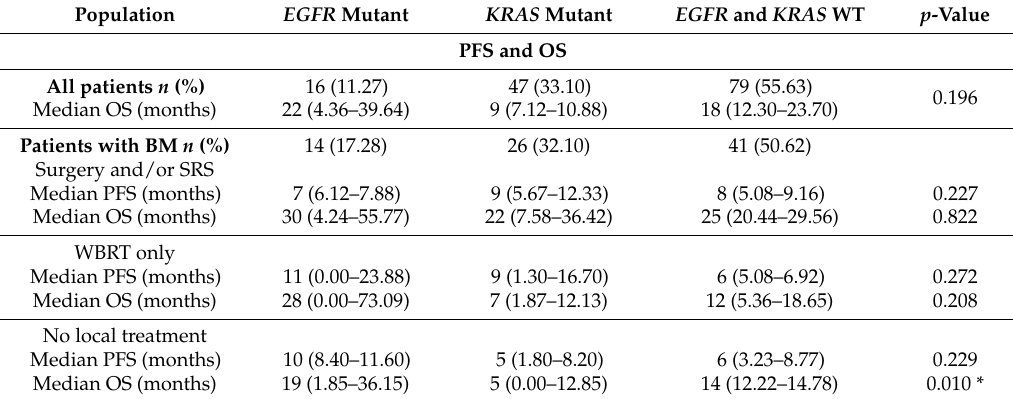
Table 4. Association between mutation status and survival. OS and PFS and mutation status in all patients and in patients with BM segregated into two groups. WT: wild type; PFS: progression free survival; OS: overall survival; SRS: stereotactic radio-surgery; WBRT; whole brain radiation therapy; *: significant p -value.